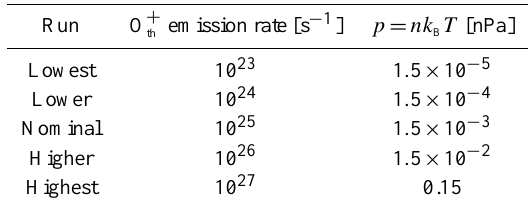
Table 2. Ionospheric O + emission rates and thermal pressures from th Eq. (8). The emission radius is 400 km and the temperature 2000K. The O + in the simulation is dominated by the exospheric photoions in the 10 23 and 10 24